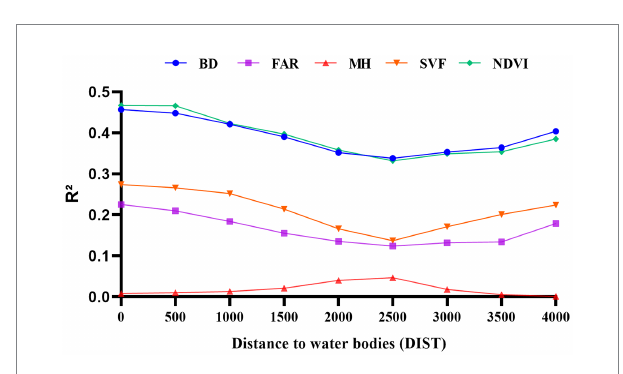
FIGURE 5 LST— R 2 of fitting coefficients of urban morphological